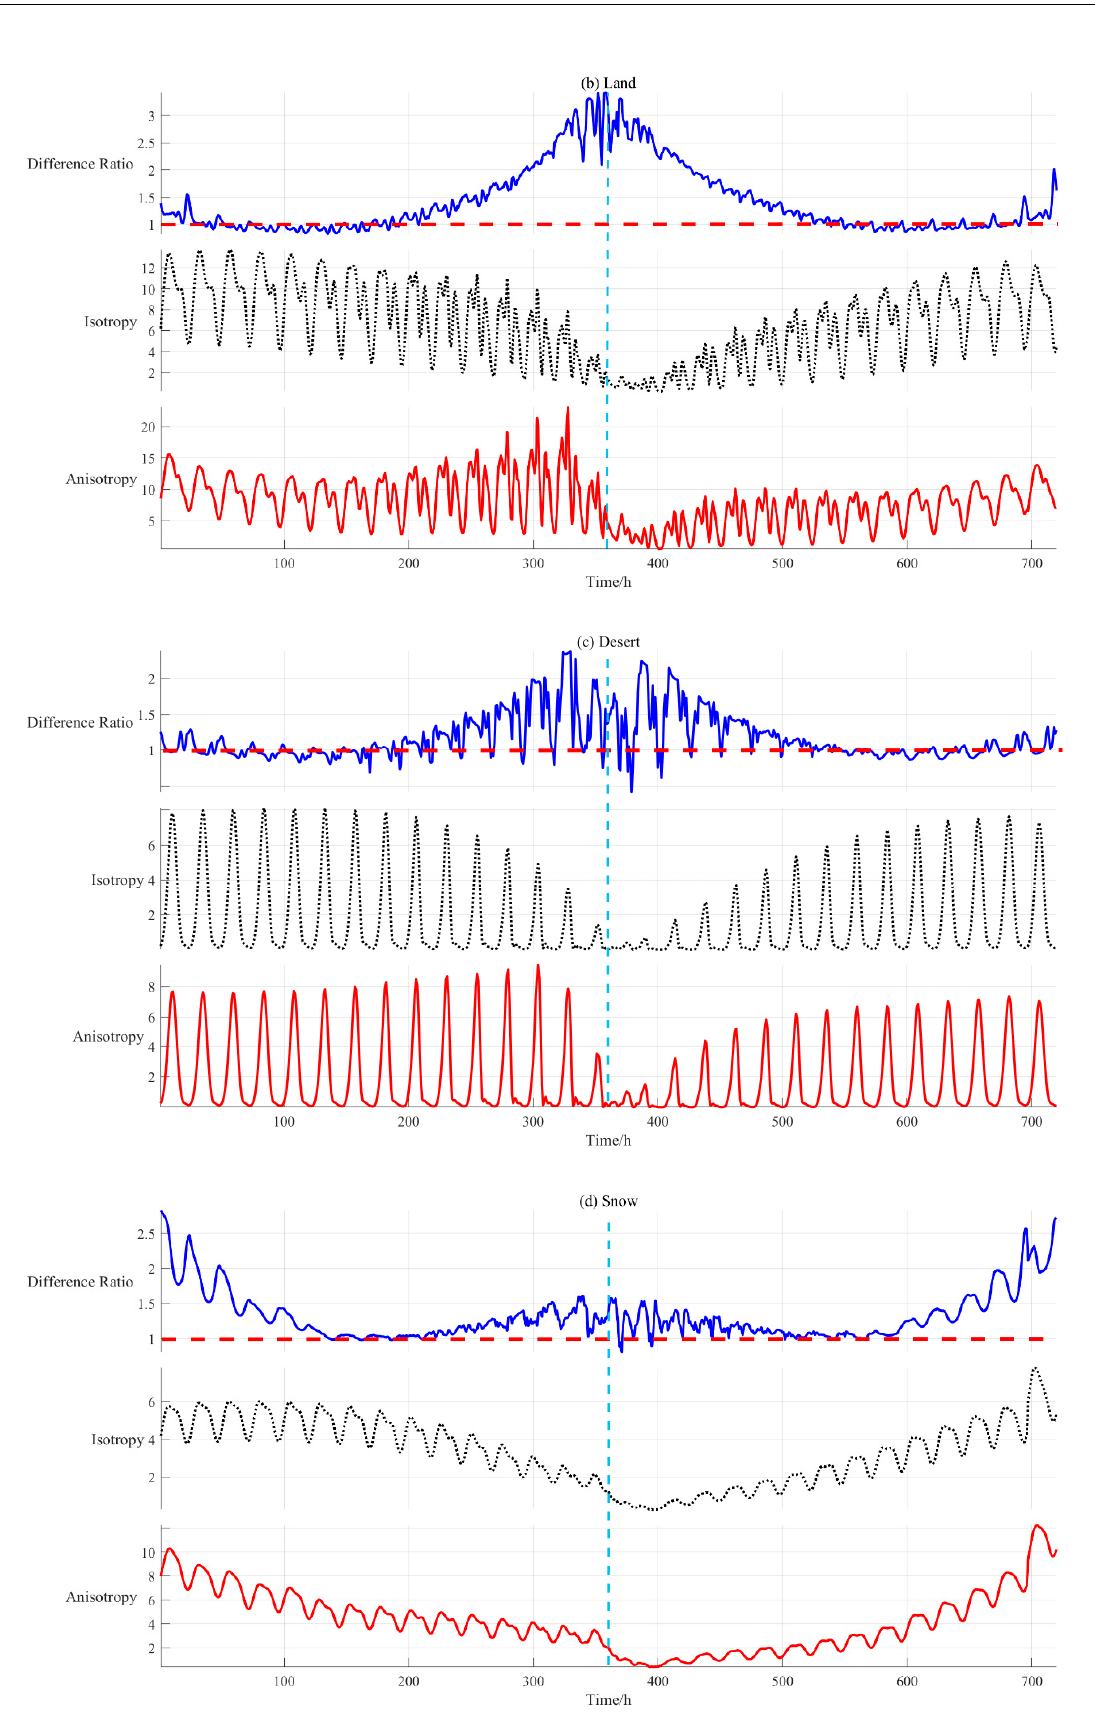
Figure 14. Comparison of the anisotropic and isotropic differences in scene types.